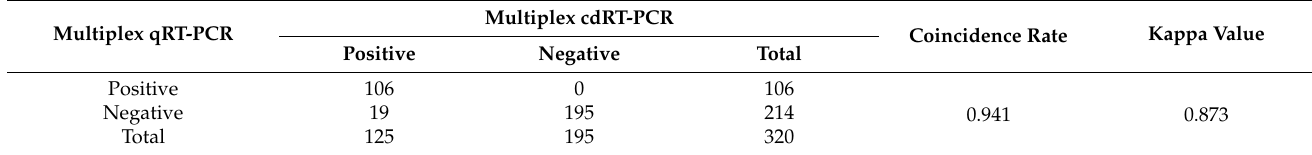
Table 5. Comparison of the results using the multiplex qRT-PCR and the multiplex